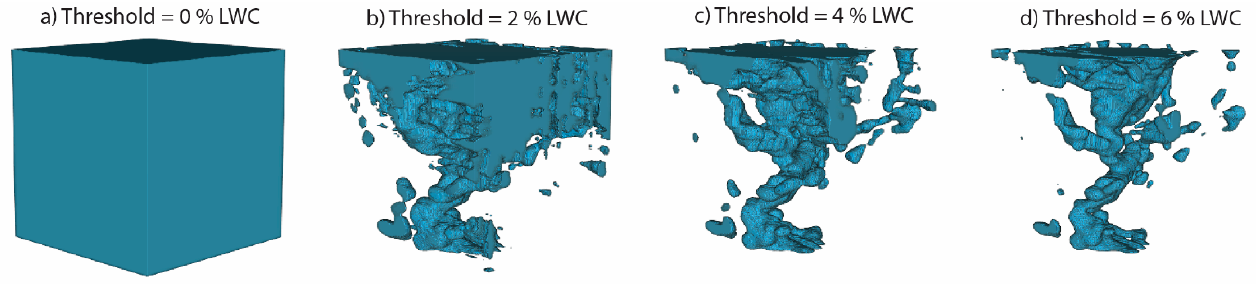
Figure 5. An example (Sample 6) of binarizing the volume of interest (VOI) using a liquid water content (LWC) threshold equal to ( a ) 0%, ( b ) 2%, ( c ) 4%, and ( d ) 6%.